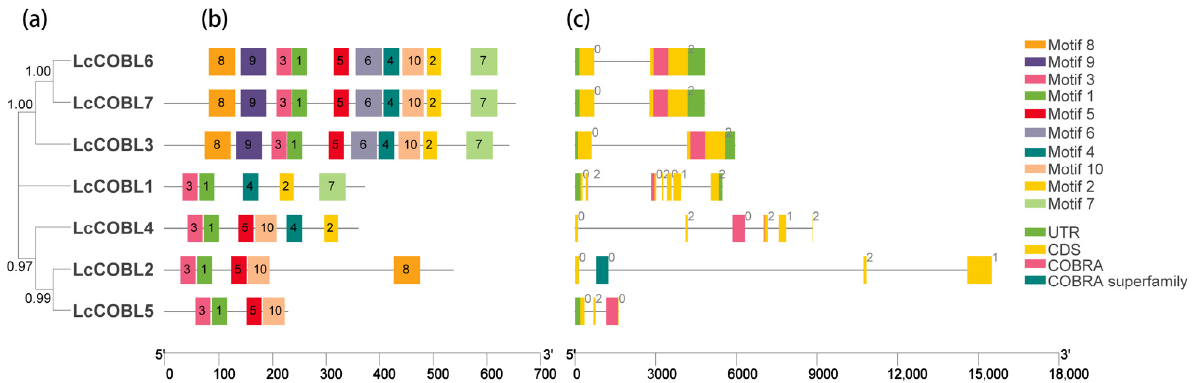
Figure 2. Conserved motifs and structures of LcCOBL genes. ( a ) ClustalW was used for multi- sequence alignment of LcCOBL protein sequences. A maximum likelihood (ML) tree was built using MEGA X and 1000 bootstrap repeats. ( b ) The conserved motifs of LcCOBL proteins were revealed using MEME analysis. The colored box on the right represents 10 motifs. ( c ) The gene structures. Yellow boxes, black lines, green boxes, pink boxes and dark green boxes represent exons, introns, UTRs (untranslated regions), COBRA domains and COBRA superfamily domains, respectively.